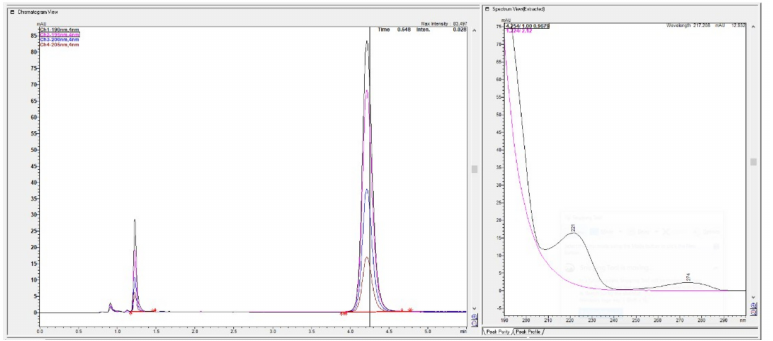
Figure 4. Chromatograms with first peak with 1.25 min of meldonium with its concave UV spectrum was overlaid with metoprolol spectrum, from the bigger peak eluted second at 4 min.